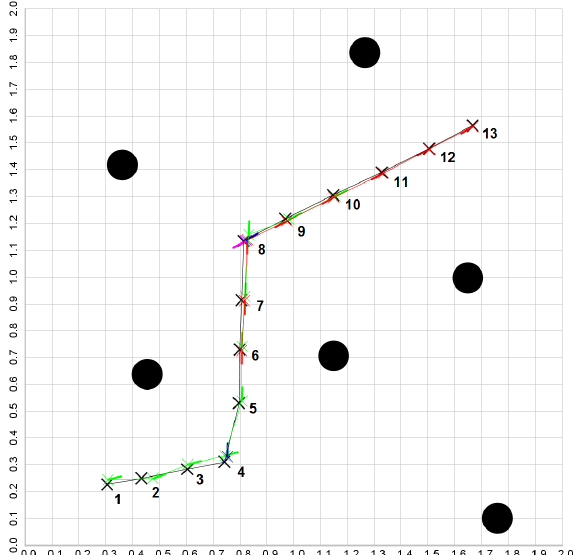
Figure 5: Example trajectory with landmarks. Reference po- sitions are marked as black cross, starting at position 1, green marks forward positions and red backwards positions. Blue and magenta indicate additional directions at turning